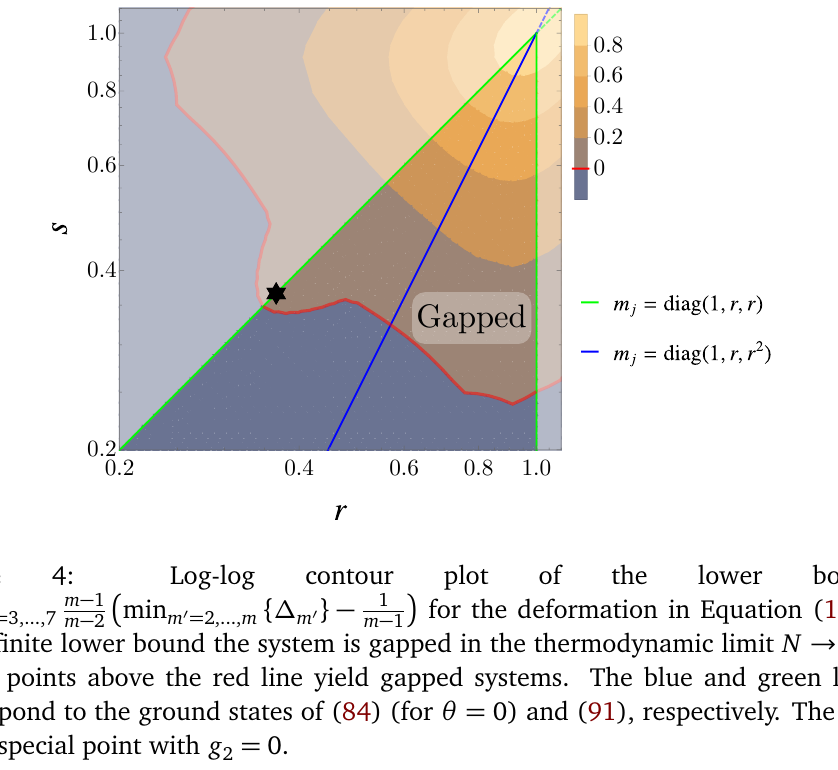
Figure 4: Log-log contour plot of the lower bound (cid:0) (cid:1) m − 1 } − 1 { ∆ max min for the deformation in Equation (139). m = 3,...,7 m (cid:48) = 2,..., m m (cid:48) m − 2 m − 1 For a finite lower bound the system is gapped in the thermodynamic limit N → ∞ , ie, all points above the red line yield gapped systems. The blue and green lines correspond to the ground states of (84) (for θ = 0) and (91), respectively. The star = is the special point with g 2